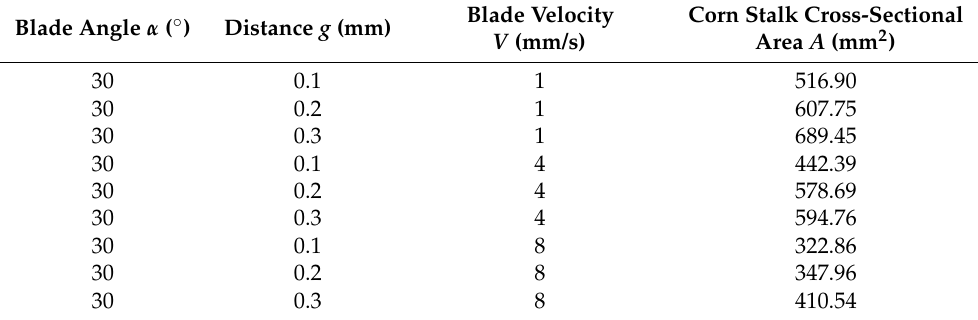
Table 1. Example values of the corn stalk cross-sectional area in elliptical shape for the blade angle α = 30 ◦ , distance g = 0.1, 0.2, 0.3 mm and blade velocity V = 1 mm/s, 4 mm/s and 8 mm/s.